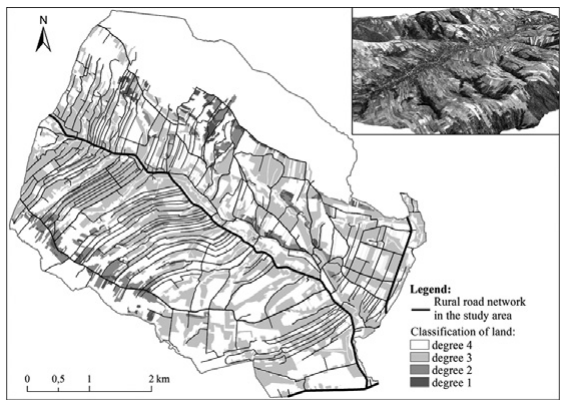
Fig. 3. The resulting map of